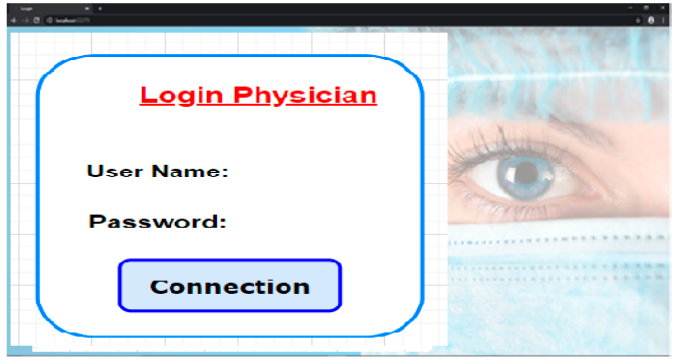
Figure 20. Connection interface.